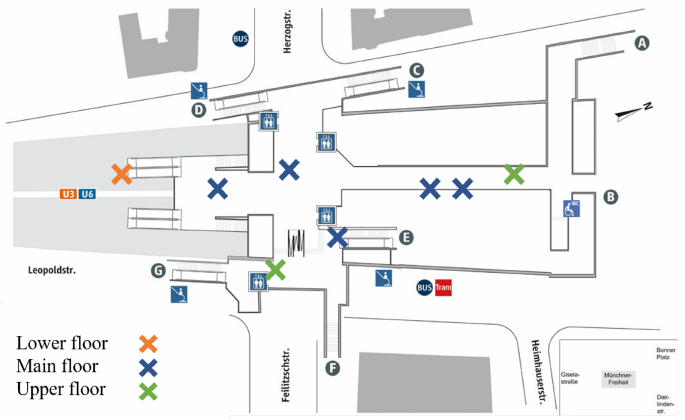
Figure 4. Map of the Ground Truth Points (GTP) in the test station.